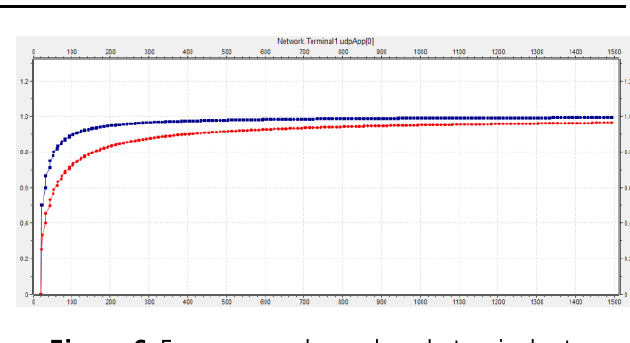
Figure 6. Free space channel packet arrival rate.